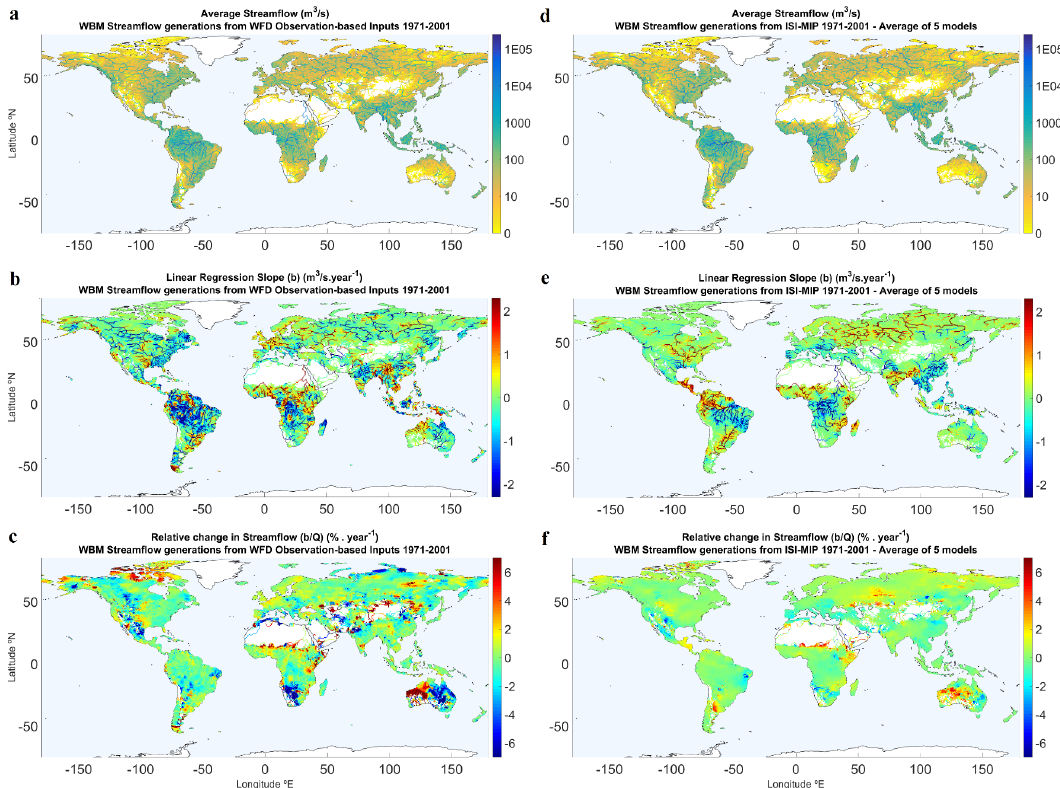
Figure 4. Global maps of WBM streamflow generated from WFD observation-based input versus ISI-MIP inputs (average of the 5 GCMs), 1971–2001—mean streamflow map for WFD ( a ) and ISI-MIP ( d ), Slope of change in mean streamflow map for WFD ( b ) and ISI-MIP ( e ), and relative change in mean streamflow map for WFD ( c ) and ISI-MIP ( f ). The values are per grid cell.